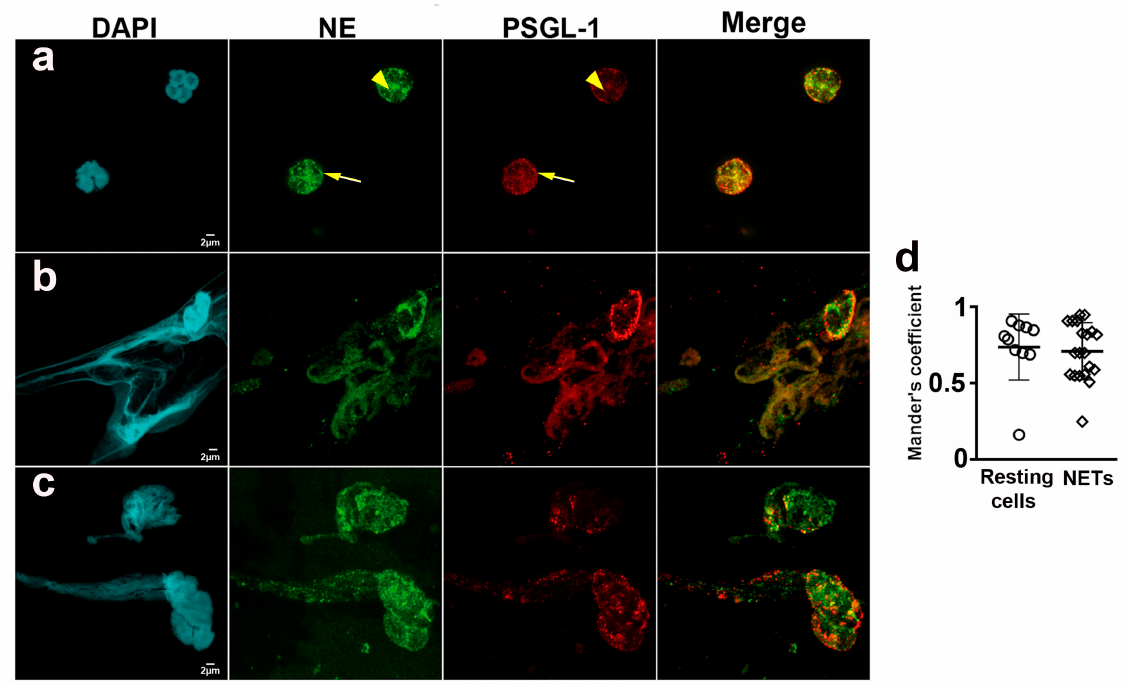
Figure 2. PSGL-1 localization in neutrophils and NETs. Representative microphotographs of neu- trophils isolated from blood of HD, after 1 h incubation on BSA and labeled with anti-PSGL-1 monoclonal antibody plus anti-mouse-Alexa Fluor555 (red) secondary antibody, anti-neutrophil elastase rabbit polyclonal antibody plus anti-rabbit-Alexa Fluor 647 (green) secondary antibody and DAPI to visualize DNA (cyan). ( a ) Resting neutrophils. ( b , c ) Spontaneous NETs. ( d ) Scatterplot rep- resenting Mander’s coefficient for PSGL-1 and NE co-localization in resting neutrophils (0.74 ± 0.21) and NETs (0.67 ± 0.21). Scale bar = 2 µ m. All images were obtained by confocal microscopy with 63 × oil objective and a 5 × digital zoom. Arrowheads indicate cytoplasmic granules. Arrows indicate the neutrophil membrane. NETs: Neutrophil extracellular traps. NE: Neutrophil elastase. PSGL-1: P-selectin glycoprotein ligand-1.